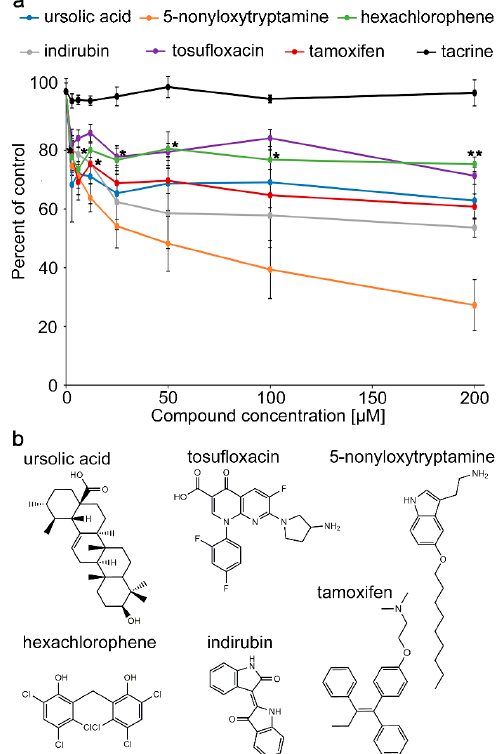
Figure 1. Small organic compounds inhibit the binding of the HNK1-specific antibody to the HNK1 mimetic peptide in a concentration-dependent manner. ( a ) HNK1-specific antibody was substrate-coated on an enzyme-linked immunosorbent assay (ELISA) plate and preincubated with different concentrations (1–200 µM) of compounds from libraries or the negative control compound tacrine. Biotinylated HNK1 mimetic peptide was then added and detected by horseradish peroxidase (HRP)-coupled streptavidin followed by development with o-phenylenediamine dihydrochloride (OPD) substrate to produce a colored product that was quantified in the ELISA reader. The signal with this peptide without compounds was set to 100%. The graph shows average relative inhibition of the signal (duplicate wells carried out in three independent experiments ± SEM). All data points below the asterisks are di ff erent in inhibition when compared to the negative control compound tacrine (one-way ANOVA, F(31 / 64) = 4.122, p < 0.0001; Fisher’s PLSD test, * p < 0.05, ** p < 0.01). ( b ) Structure of the HNK1 mimetic